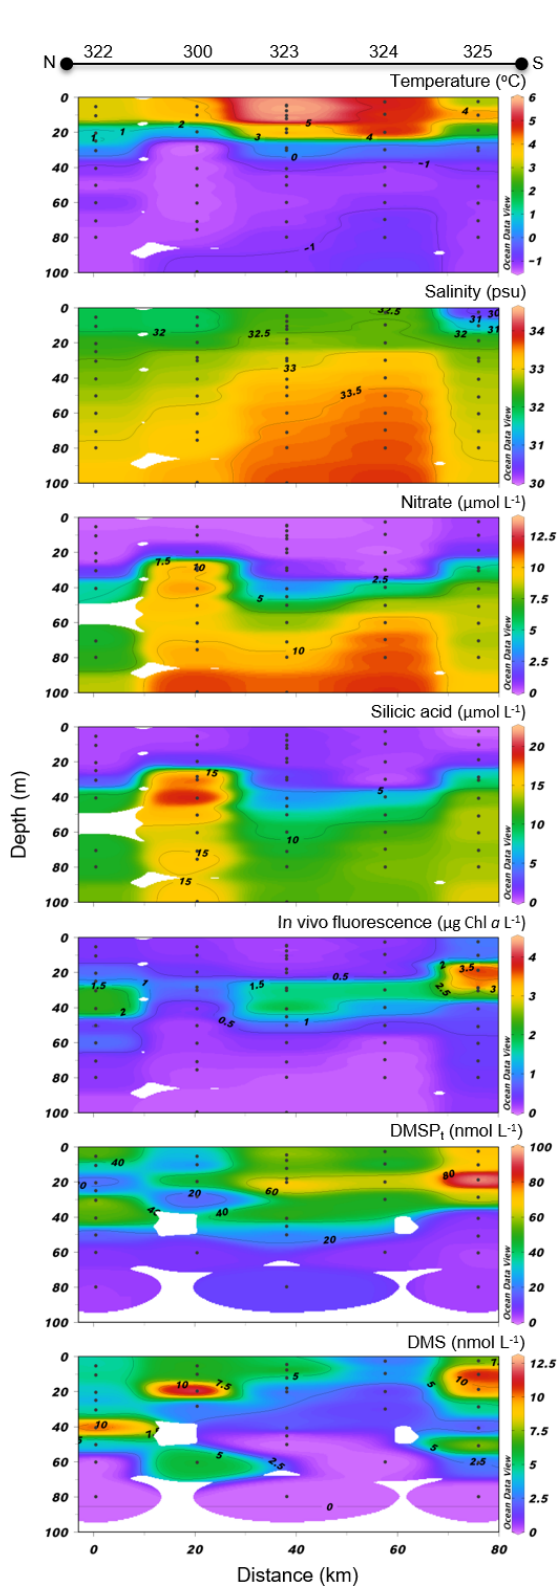
Figure 5. Lancaster Sound (LS) cross section of the vertical distri- butions of temperature, salinity, nitrate, silicic acid, in vivo fluores- cence, DMSP t , and